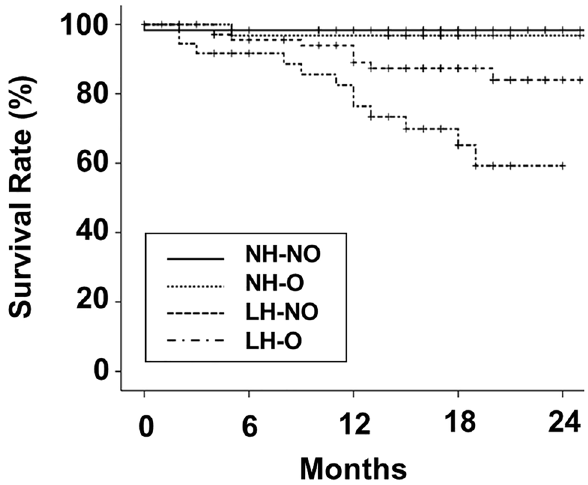
Figure 2. Kaplan–Meier curves of patient survival according to groups. LH-O vs NH-NO, NH-O, or LH-NO, P < 0.05; NH-NO vs LH-NO, P < 0.05; Other comparisons, P > 0.05.